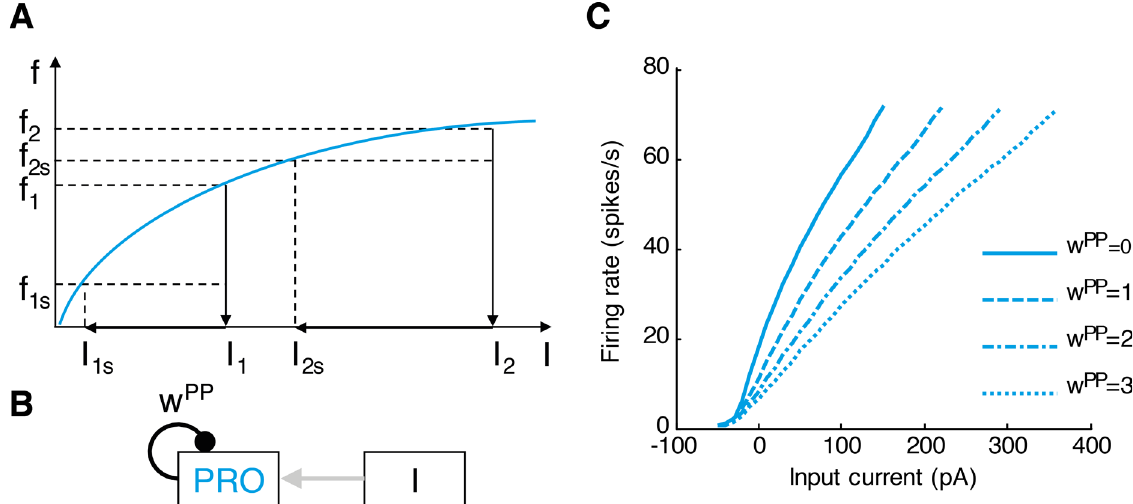
Fig 5. The connections between prototypic neurons linearize their response profiles. (A) A schematic diagram illustrating how mutual inhibition linearizes the response profile (see main text). (B) A model of a population of prototypic neurons, PRO, receiving excitatory input (I) and mutual inhibition (average weight w PP ). (C) The resulting response profiles for different levels of inhibition within the population (when w PP = 0, there is no mutual inhibition). Note the linearization of the population response with increasing mutual